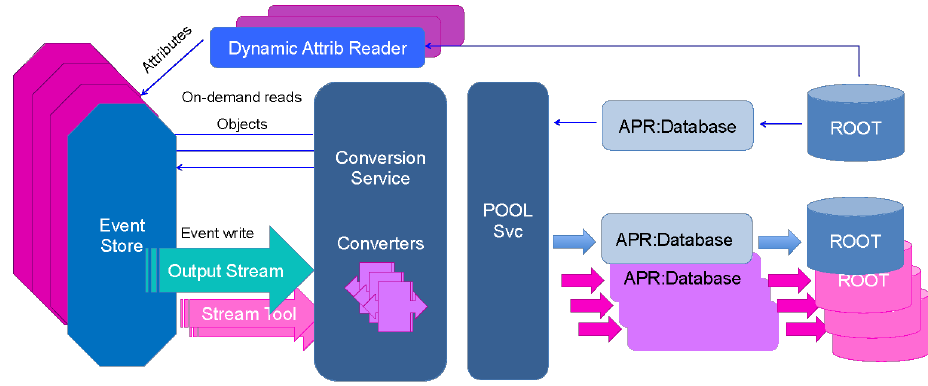
Figure 1. I/O Framework evolution from Single-Process (blue) to Multi-Threaded (all). Reading Events from input is done sequentially in AthenaMT. However, certain data elements are read on-demand during processing and such requests can happen